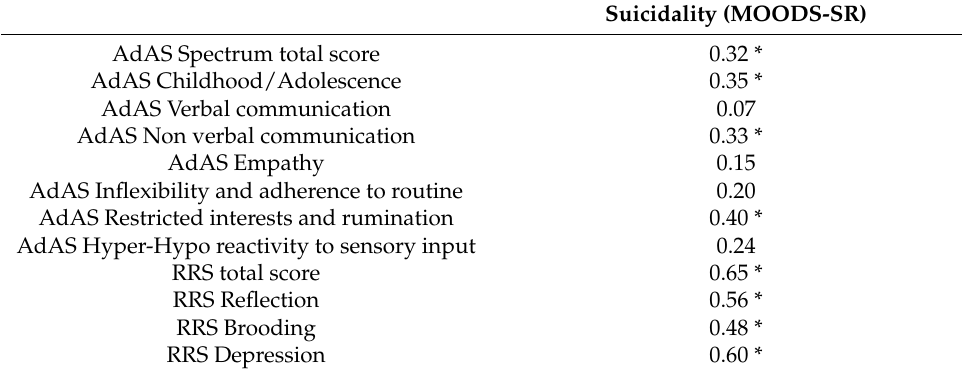
Table 2. Pearson’s c orrelations coefficients (r) among Suicidality score and Adas Spectrum/RRS scores in the BPD